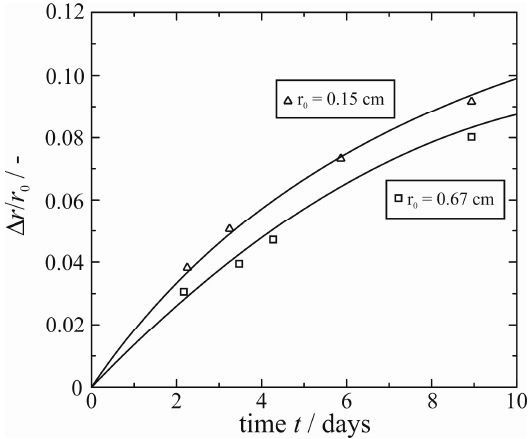
Figure 5. Radial shrinkage of gel cylinders as a function of different initial radii [1].